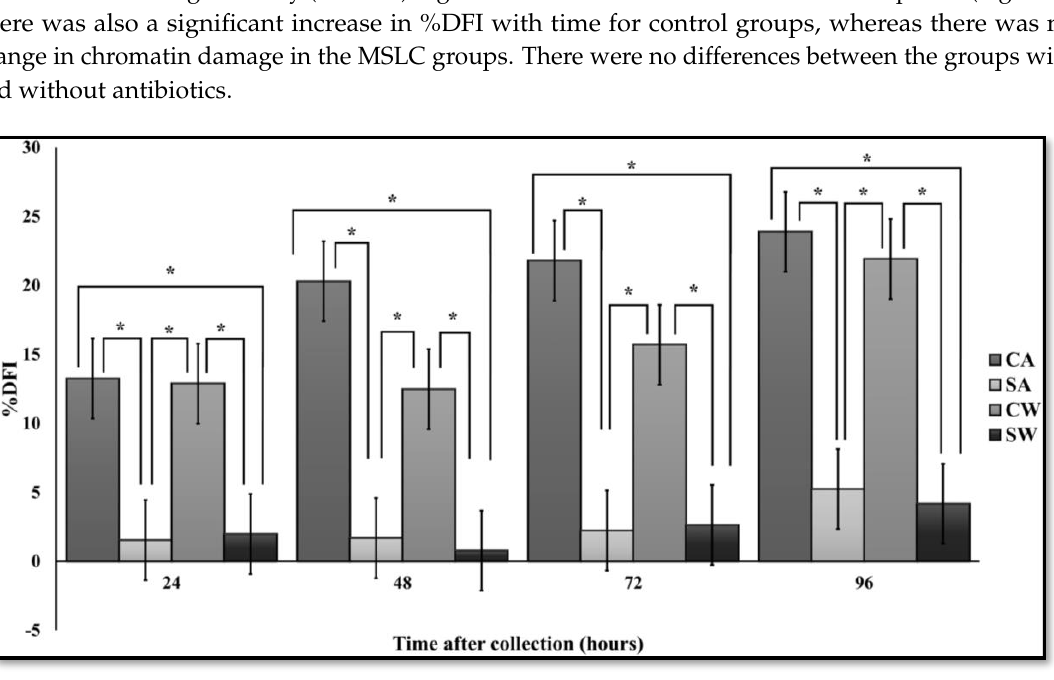
Figure 4. DNA fragmentation index for control and MSLC samples, with and without